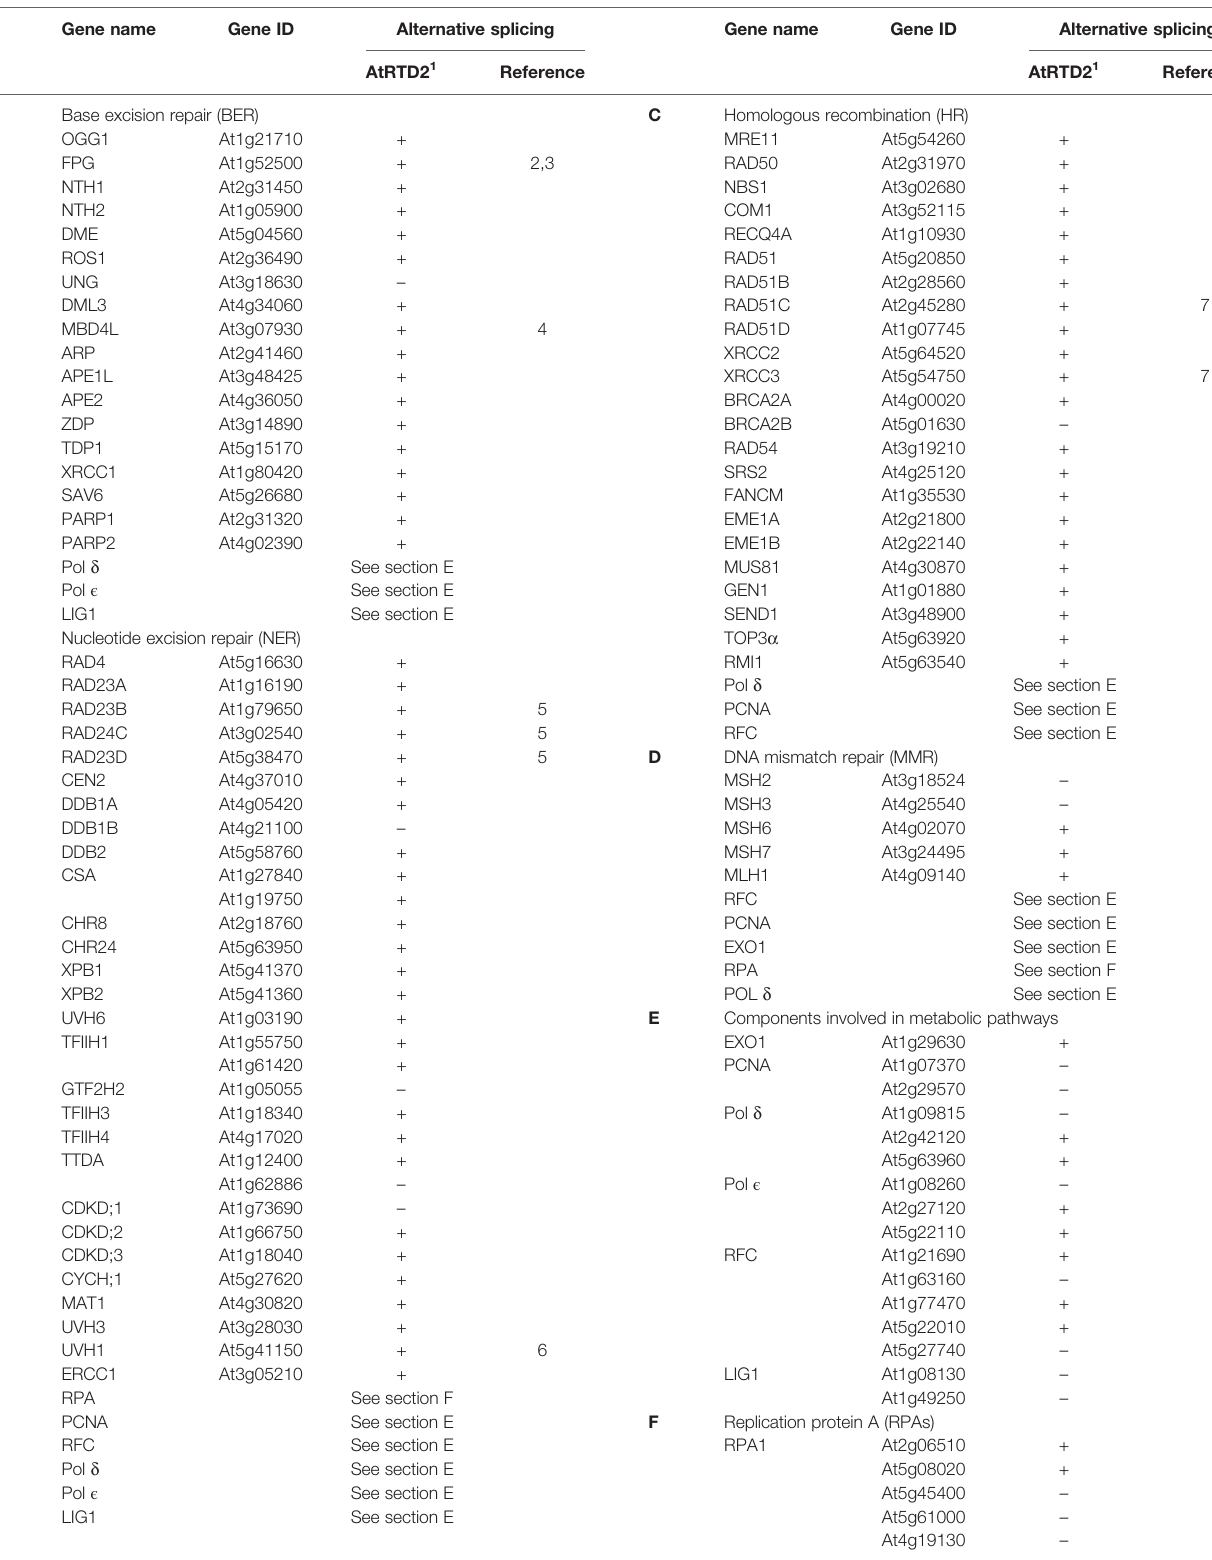
TABLE 1 | Overview of alternative splicing in genes involved in DNA damage